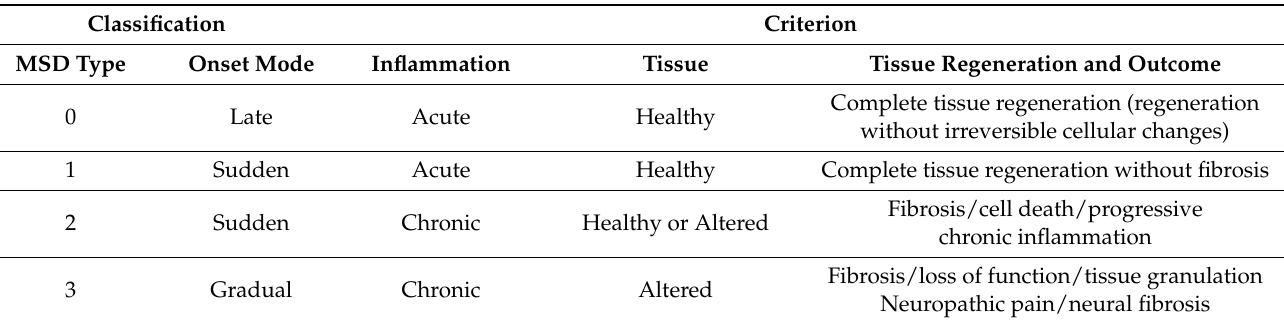
Table 2. Criteria according to lesion pathophysiology and onset